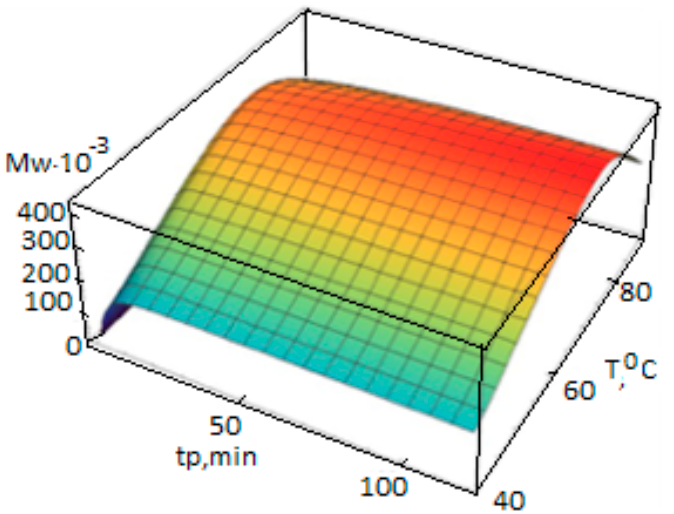
Figure 5. Dependence of the average mass molecular weight of PP on the temperature T and the polymerization duration t p , calculated according to the polycenteric model using the activation energies from Table 3 (polymerization conditions in Table 2).